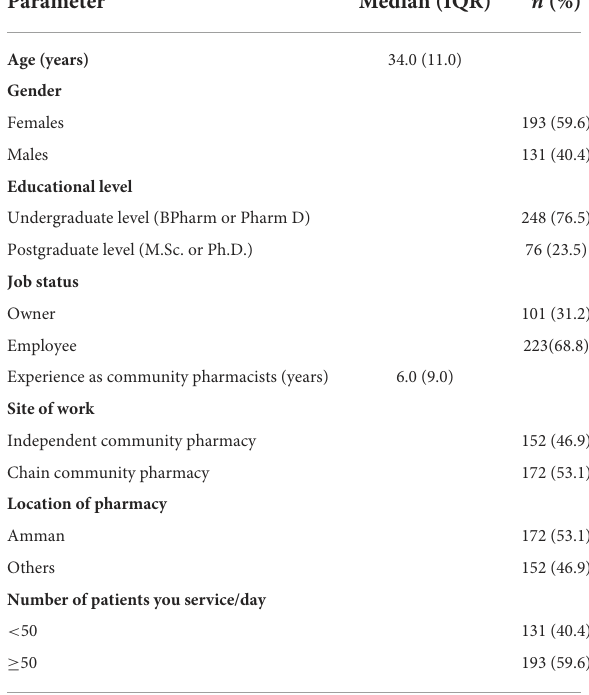
TABLE 1 Socio-Demographic characteristics of the study respondent ( n =